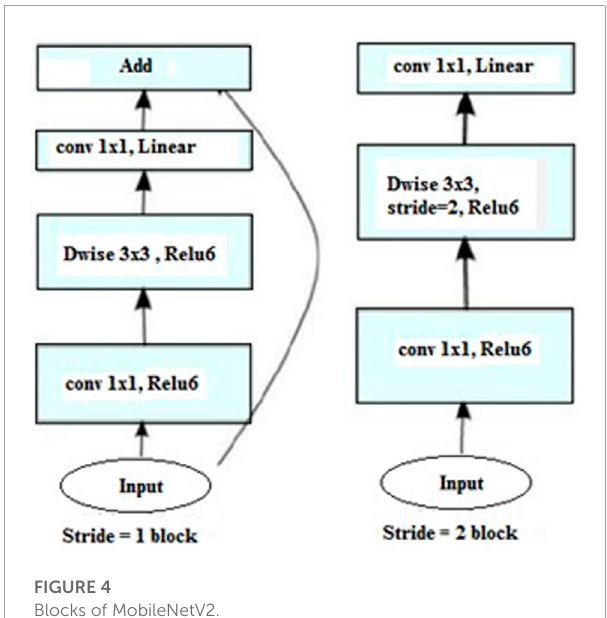
FIGURE 4 Blocks of